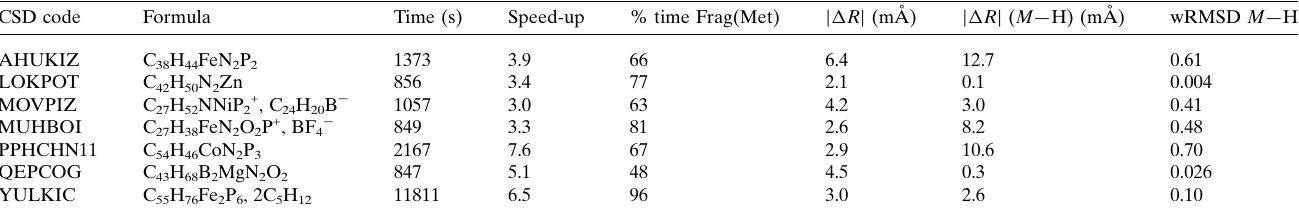
Table 3 Results of fragmentation for systems with metal–hydrogen bonds including. (1) Calculation time for the non-fragmented system, (2) acceleration, (3) calculation time for the fragment containing metal as a percentage of the total calculation time [% time Frag(Met)], (4) average X —H bond length deviation between regular and fragmentation-based HAR and the non-fragmented version of HAR ( j (cid:2) R j ), (5) deviation for the metal–hydrogen bond [ j (cid:2) R j ( M —H)] and (6) wRMSD for the metal–hydrogen bond ( M —H).